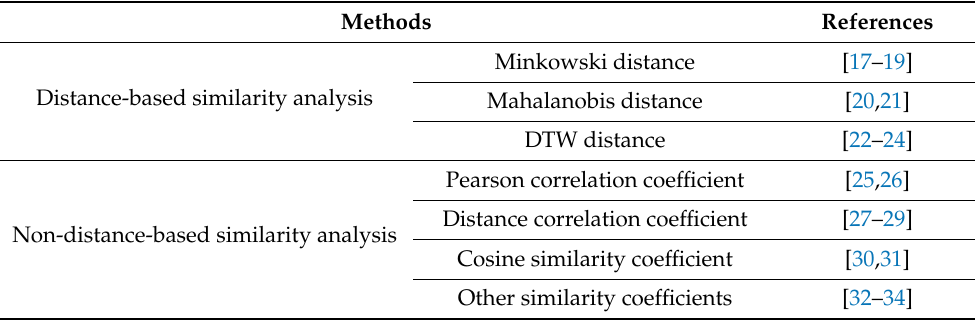
Table 1 summarizes various similarity metrics and the corresponding references. Table 1. Summary of similarity analysis and references.